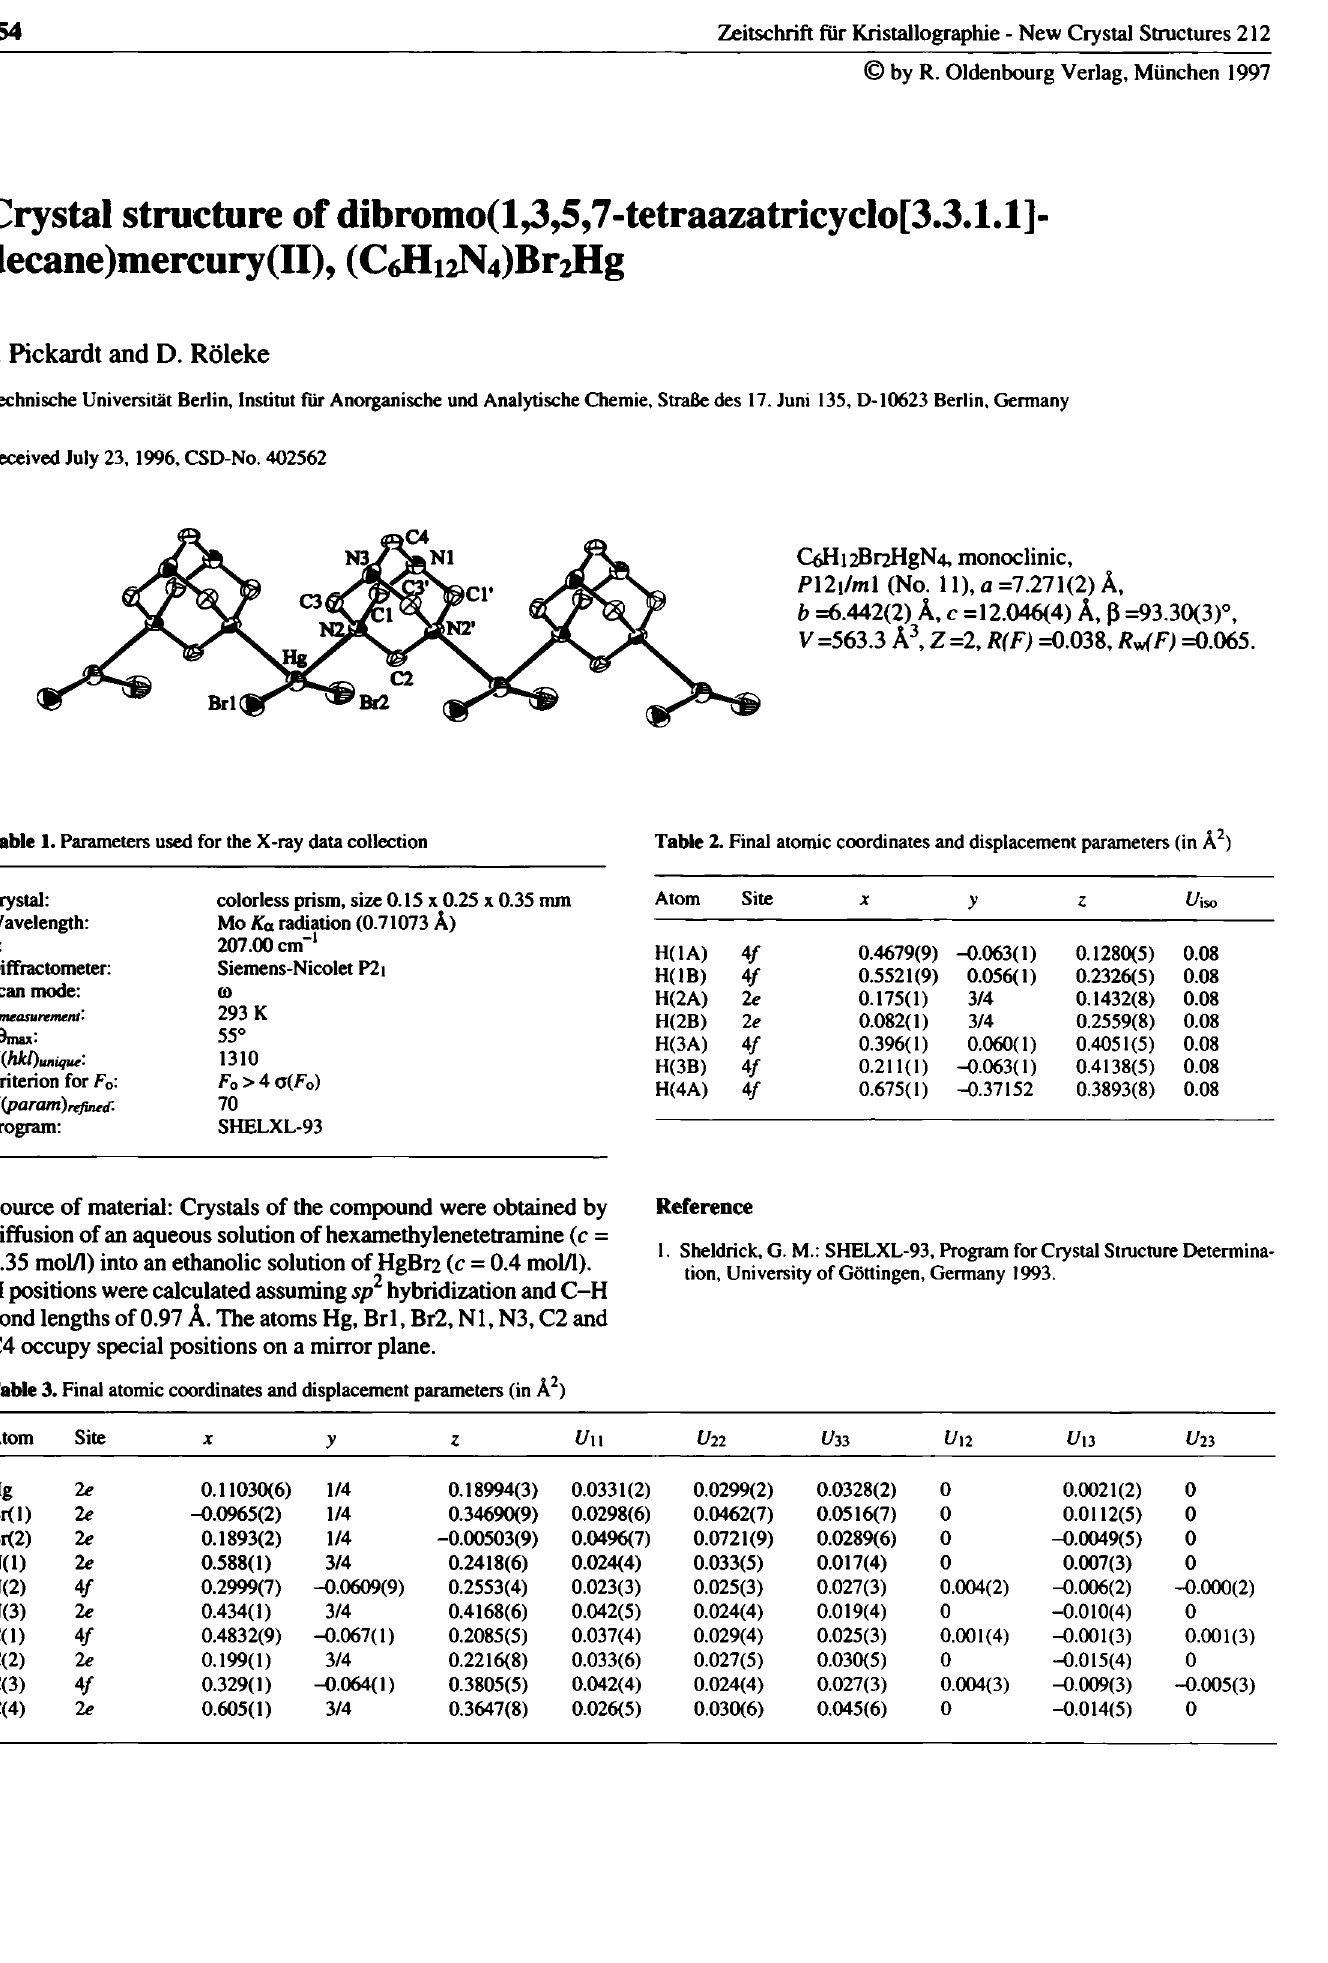
Table 2. Final atomic coordinates and displacement parameters (in Â 2 )